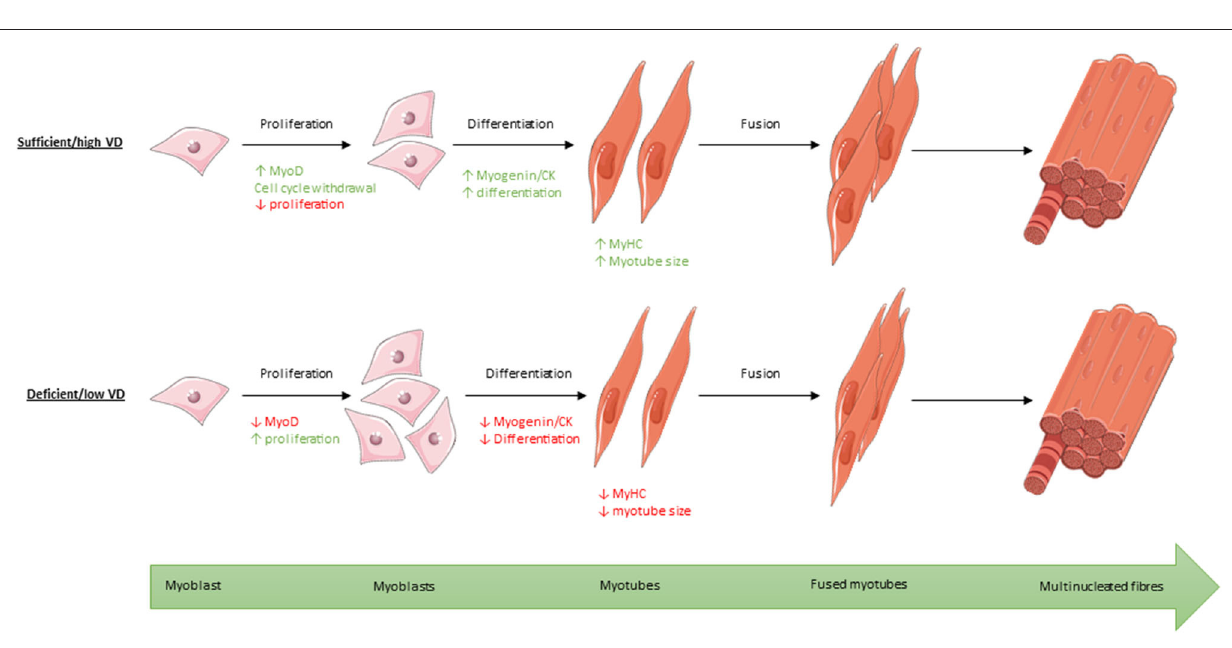
FIGURE 8 | Process of myogenic differentiation from myoblasts to multinucleated muscle fibres showing the effect of high/sufficient active vitamin D (VD) on various transcription factors within the process compared to low/deficient levels. Images used within this figure were obtained from smart servier medical art and can be found at